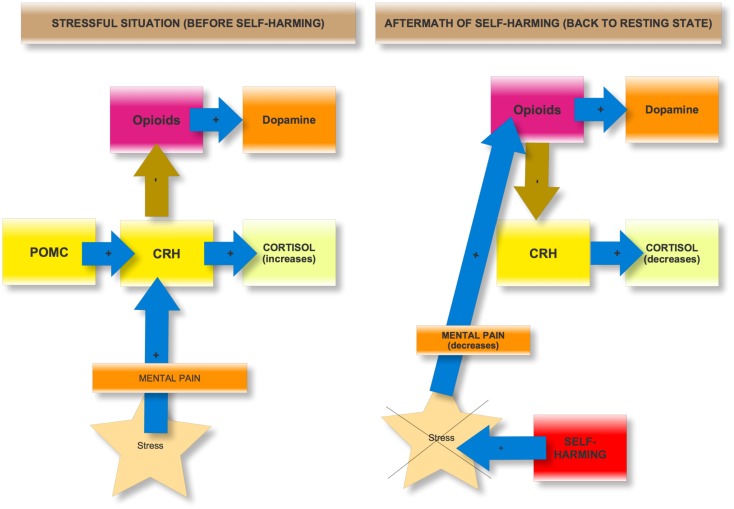
Basic neurobiological mechanisms involved in the addiction to self-harming.